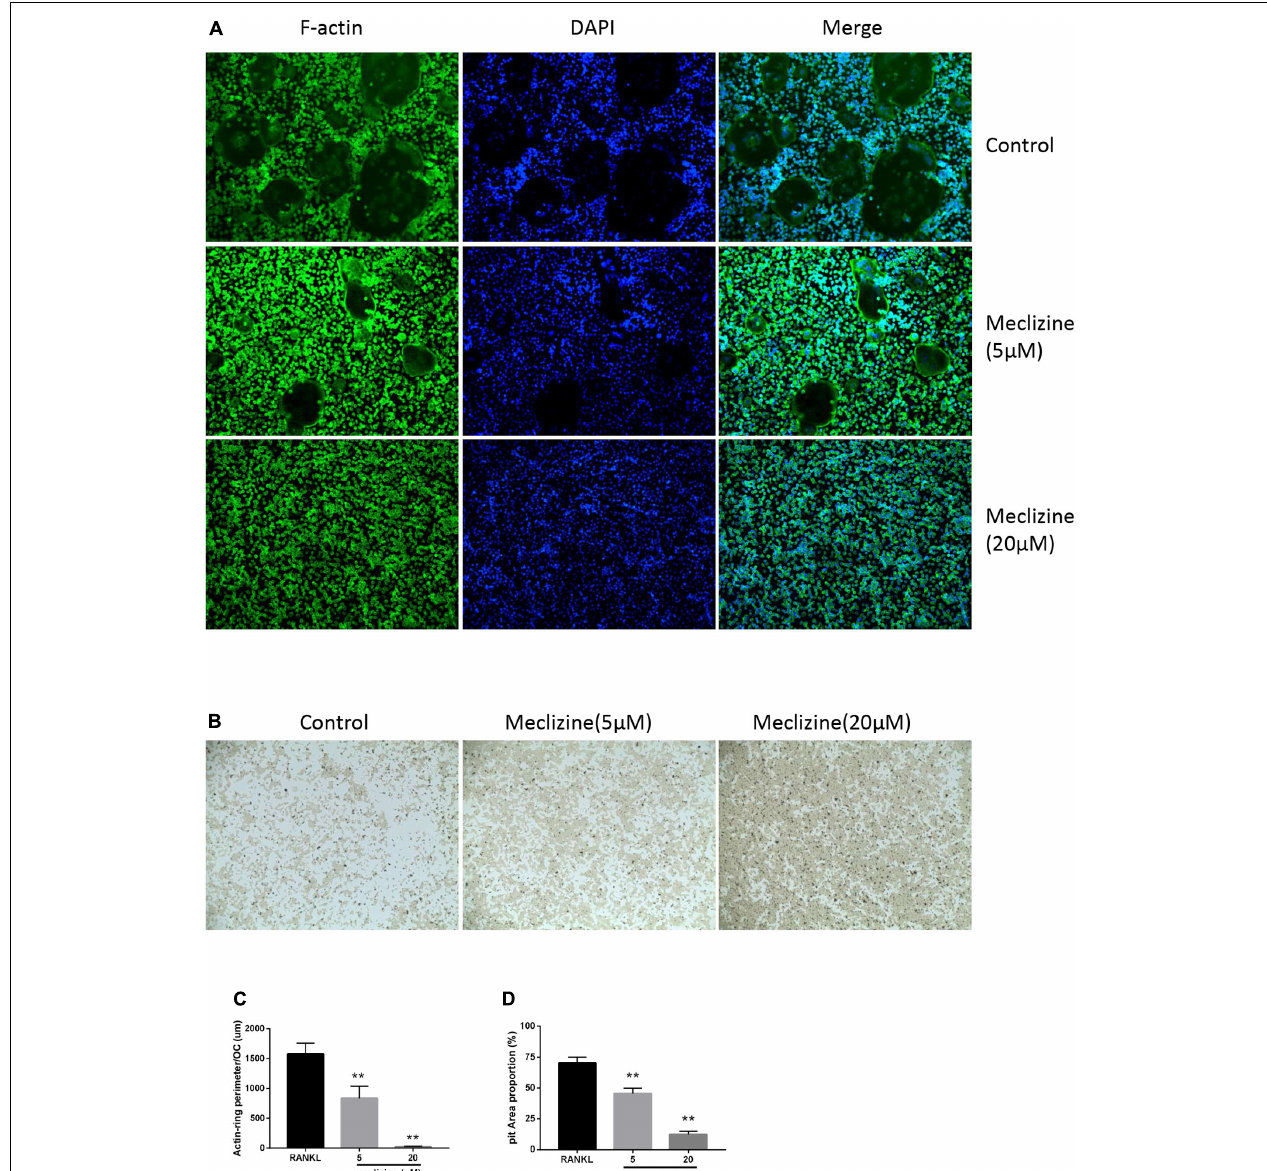
FIGURE 3 | Meclizine suppresses actin ring formation and osteoclast function. (A,C) Meclizine disrupts actin ring formations. Staining for actin ring formation was performed after culturing for 4 days. Typically fluorescence microscopy images of BMMs (1.0 × 10 4 cells/well) treated with meclizine (0, 5, 20 µ M) are shown and the perimeters of actin rings were measured. Data are presented as means ± SD. ∗∗ P < 0.01 versus RANKL group. (B,D) Meclizine inhibited the bone resorption activity of osteoclasts. BMMs (2.0 × 10 4 cells/well) seeded onto a Corning Osteo Assay Surface were treated with RANKL (100 ng/mL) and M-CSF (30 ng/mL) for 4 days and subsequently treated with 0, 5 or 20 µ M meclizine for an additional 4 days. Images of erosion pits were taken and the percentage of erosion area (blank area)/total area was determined. Data are presented as means ± SD of 3 independent experiments; ∗∗ P < 0.01 versus RANKL